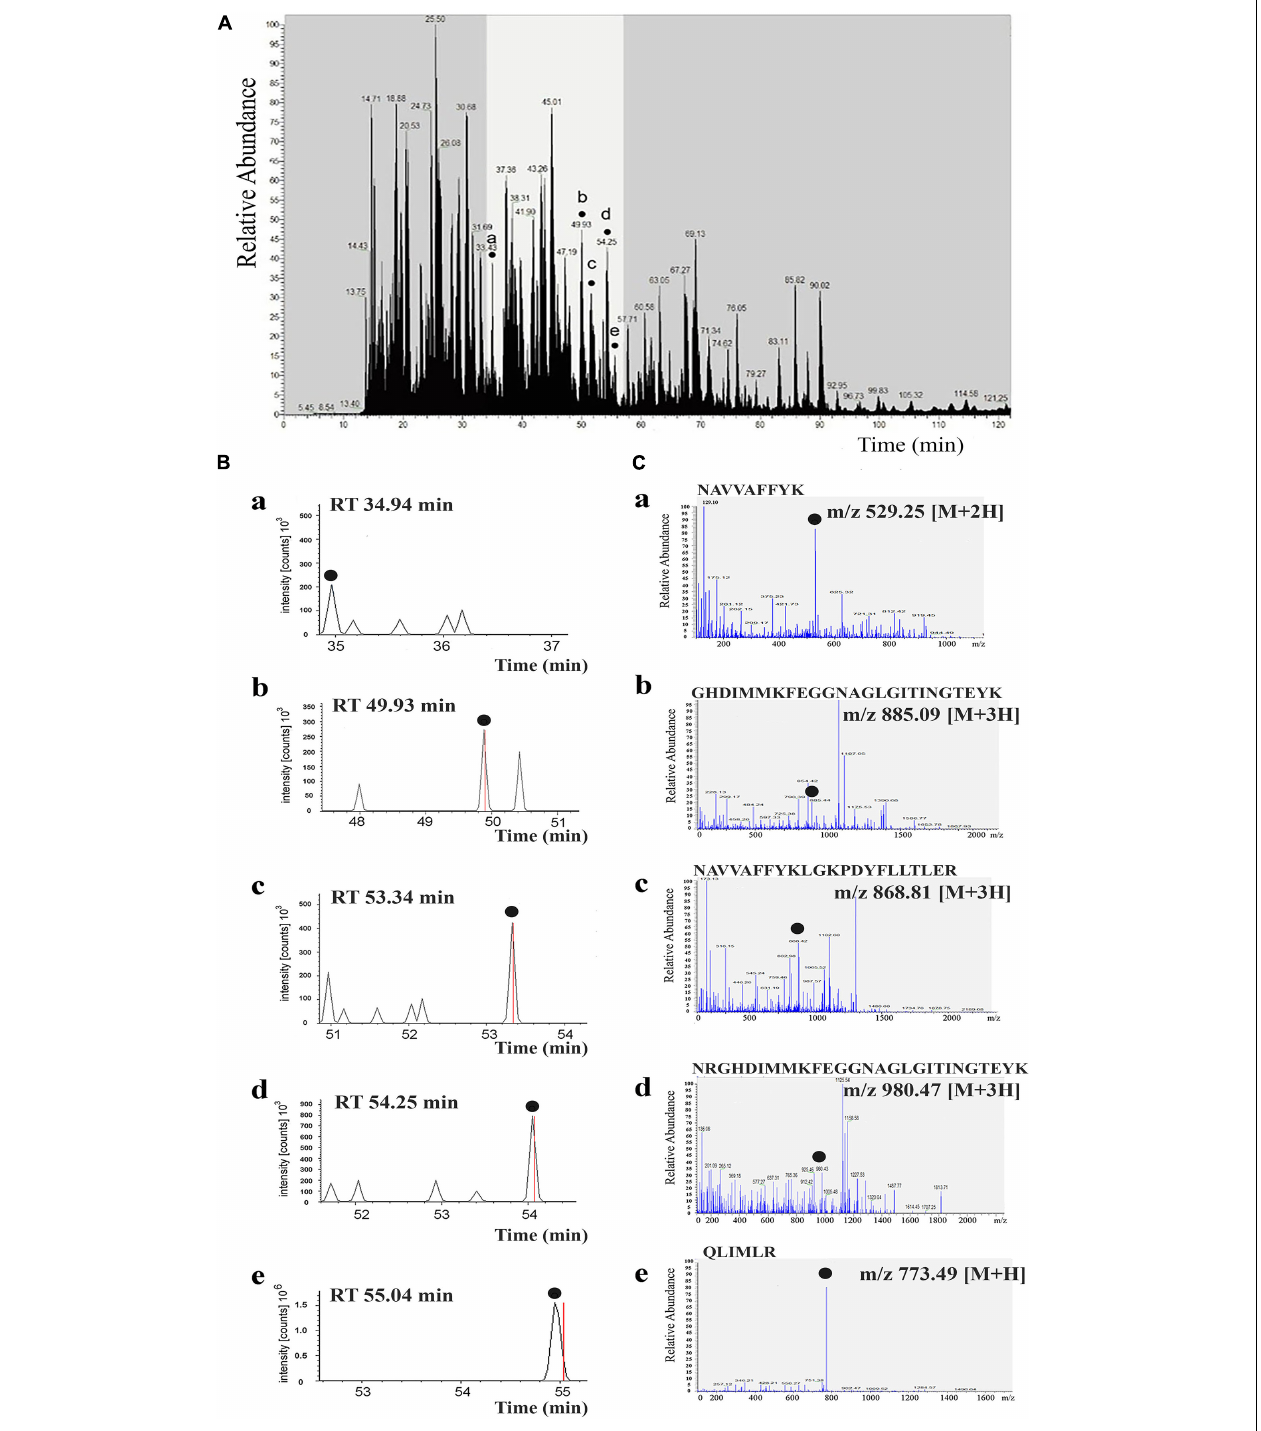
FIGURE 4 | Tandem mass spectra of identified peptides of α CA5 from Arabidopsis thaliana . Liquid chromatography–tandem mass spectrometry (LC-MS/MS) chromatogram from trypsin digestion of the protein band with carbonic anhydrase (CA) activity after non-denaturing electrophoresis of thylakoid membranes (STM). Five peptides of α CA5 were identified, shown by dots a–e, denoting peptide peaks. These peaks correspond to amino acid sequences in the predicted primary structure of the product of the At1g08065 gene, encoding α CA5 from A. thaliana (A) . Extracted ion chromatograms of five peptides (plots a–e) corresponding to the retention time (RT) of each peptide on the LC-MS/MS chromatogram (B) . MS/MS spectra obtained in data-dependent mode with an automatic switch between a full scan and up to seven data-dependent MS/MS scans. MS/MS spectra corresponding to each extracted ion chromatogram of five peptides are shown. The amino acid sequence and m / z ratio of each peptide is indicated at the top of each panel (C)